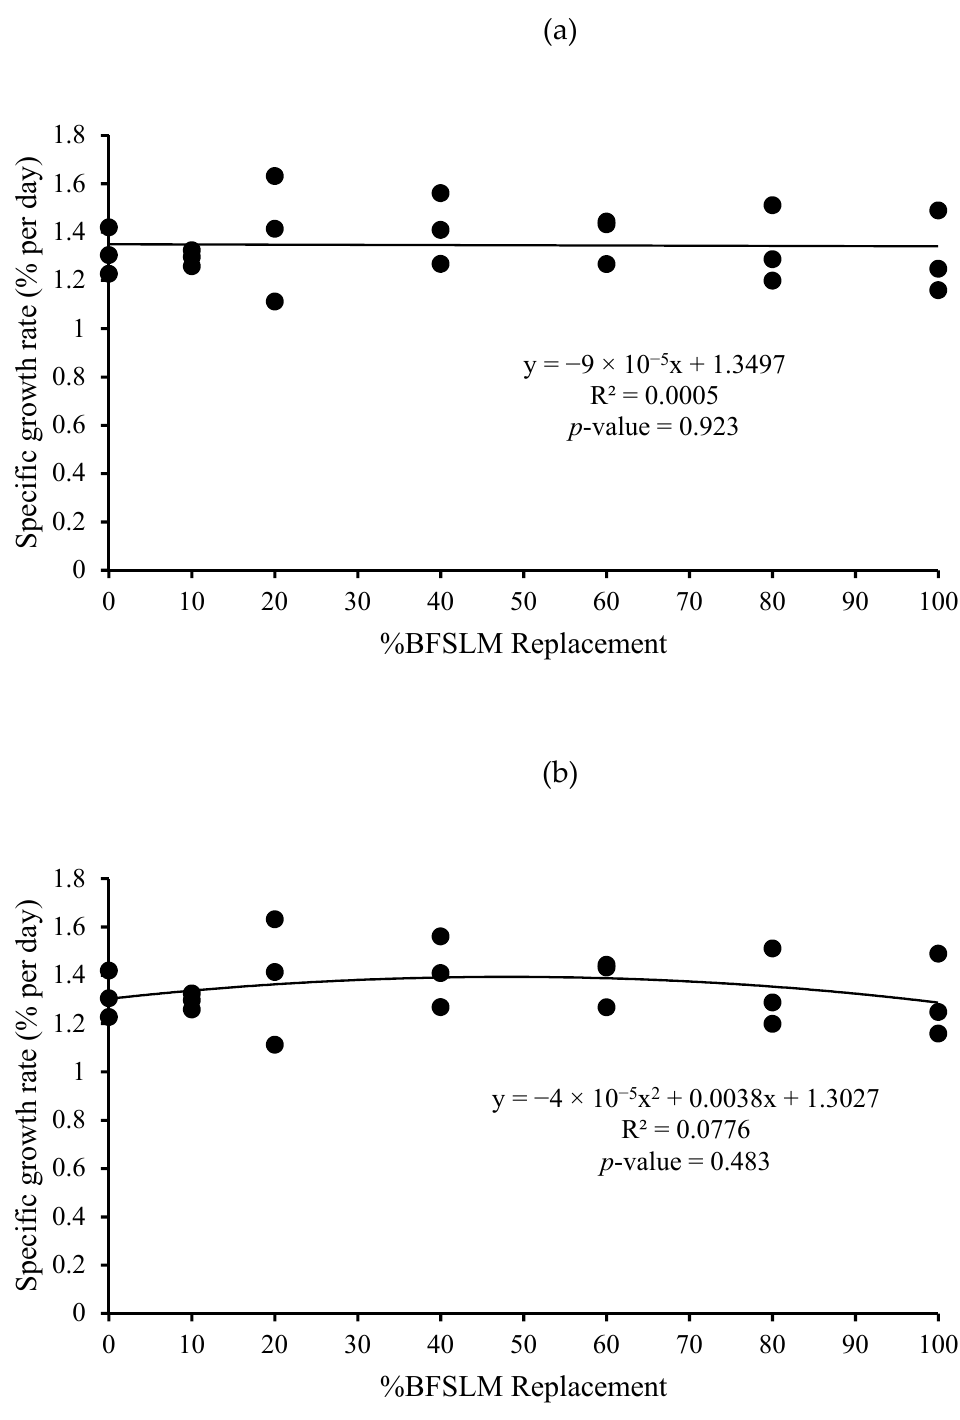
Figure 5. Linear ( a ) and quadratic ( b ) estimate: When X = %BSFLM replacement; Y = Specific growth rate after 12 weeks of feeding with control (0% BSFLM and 100% FM), and FM replaced at 10%, 20%, 40%, 60%, 80%, and 100% of the BSFLM.